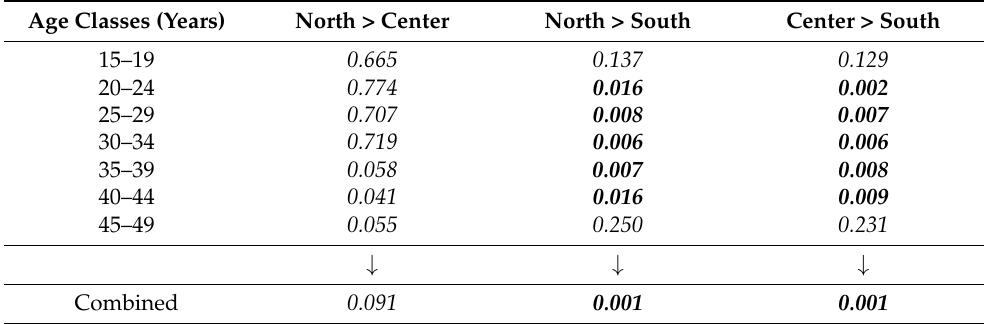
Table 4. Partial and combined p -values of two-by-two comparison between macro-areas, stratifying for age classes, for only IA.